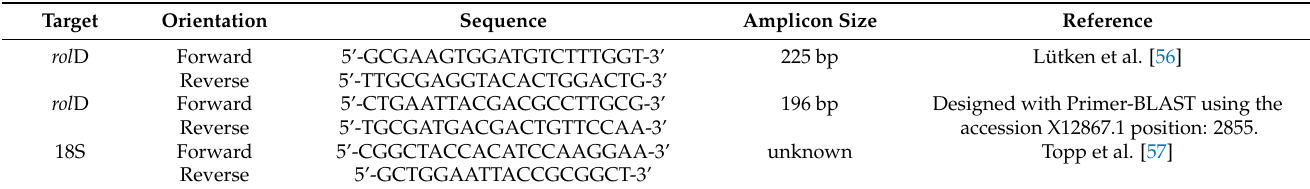
Table 1. List of primers targeting fragments of rol D, vir D, and 18S.